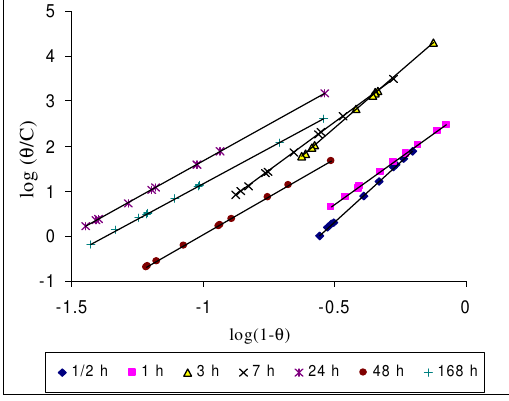
Figure 6. Flory Huggins isotherm.